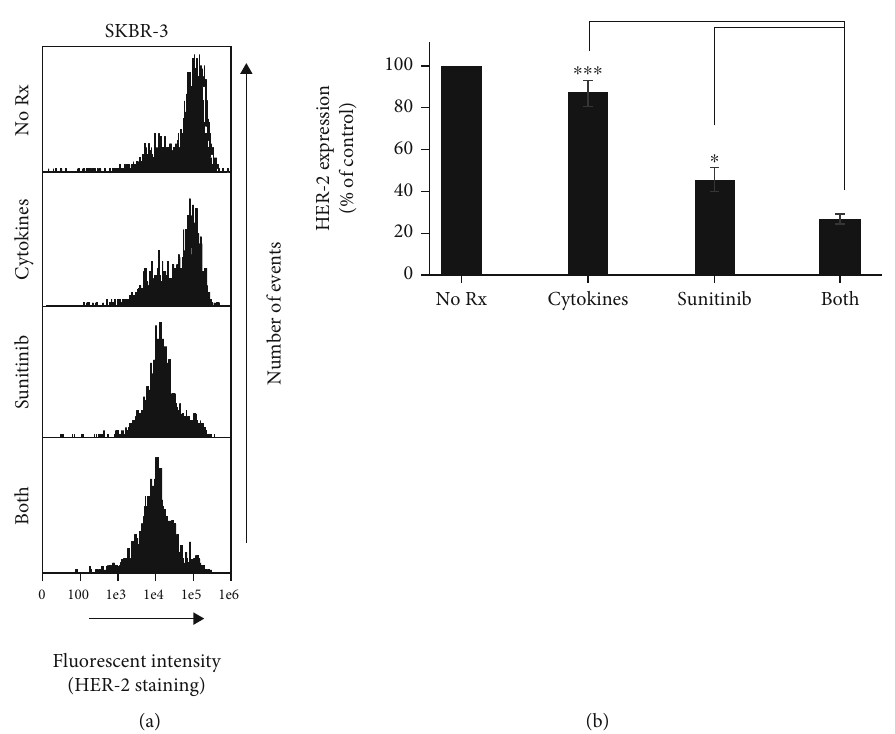
Figure 5: Dual treatment signi fi cantly suppresses HER-2 expression compared with single treatments. SKBR-3 cells were seeded at 5 × 10 4 per mL and were left either untreated (No Rx) or treated with Th1 cytokines (5 ng/mL), sunitinib (10 μ M), or sunitinib and Th1 cytokines (both) for 72 hours. Cells were harvested and stained with APC-labeled anti-HER-2 antibody and evaluated by fl ow cytometry using a 642nm excitation laser. (a) Histogram analysis of HER-2 expression from a single representative experiment. (b) Composite data analysis of mean channel fl uorescence from three separate experiments for each treatment group. Statistical signi fi cance was determined by one- way ANOVA: ( F ð 3, 20 Þ = 65 : 7 , p < 0 : 001 ) followed by Tukey post hoc analysis. Signi fi cance was set at ∗∗∗ p < 0 : 001 , ∗∗ p < 0 : 01 , and ∗ p < 0 : 05 . Error bars represent the standard error of the